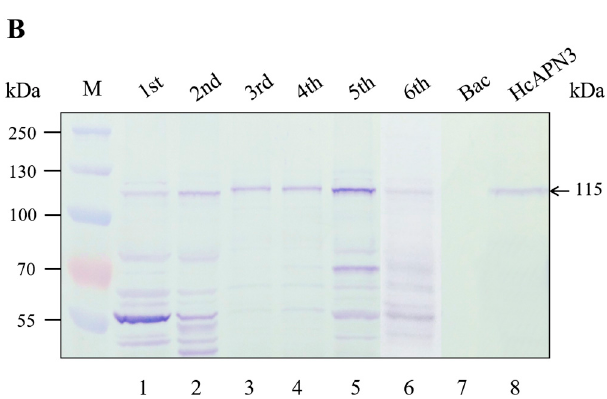
Figure 6. Detection and characterization of HcAPN3 expressed in H. cunea BBMV from different development larval stages and infected Sf9 cells. Protein from BBMV prepared from different developmental instars (lane 1–5), Sf9 cells containing control baculovirus alone (lane 6) and Sf9 cells infected with recombinant baculoviruse (lane 7) were separated by 10% SDS-PAGE and electrotransferred to PVDF membrane. ( A ) Western blot analysis of the expression of HcAPN3 with anti-HcAPN3 antibodies; ( B ) Binding detection of Cry1Ab35 toxin to HcAPN3 by ligand blot assay with anti-Cry1Ab35 antibodies. Lane M shows molecular weight markers and arrows indicate the position of the HcAPN3 protein in H. cunea BBMV.